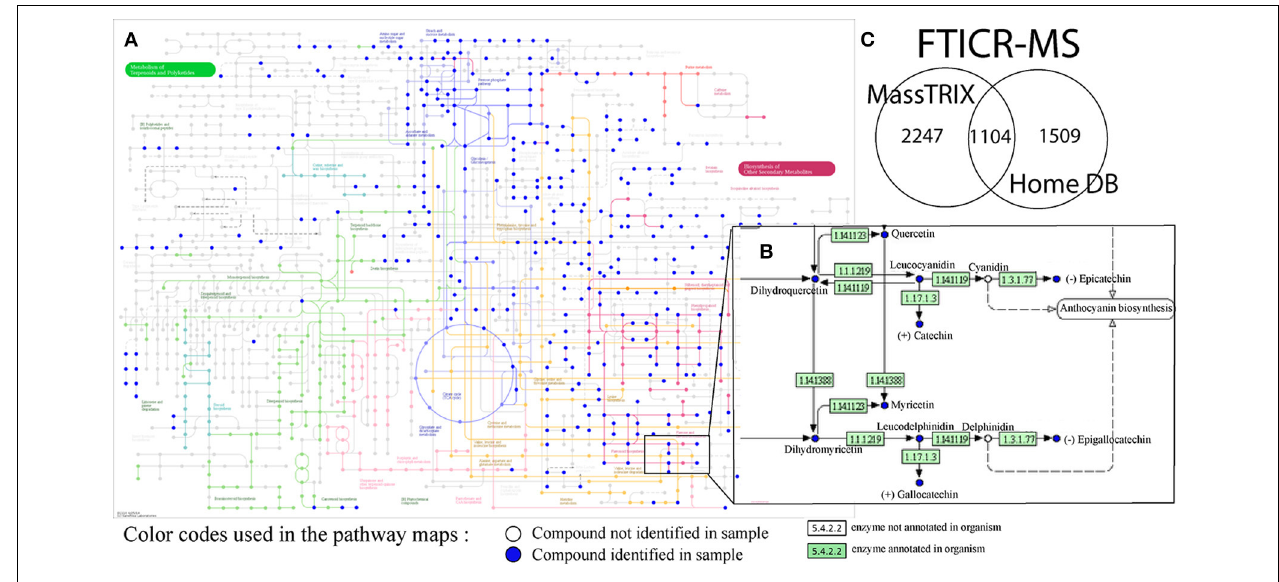
FIGURE 2 | (A) Pathways for the biosynthesis of secondary metabolites from KEGG for the vitis vinifera organism and (B) enlargement of a portion of flavonoid biosynthesis pathways, with annotated compounds (blue dots)